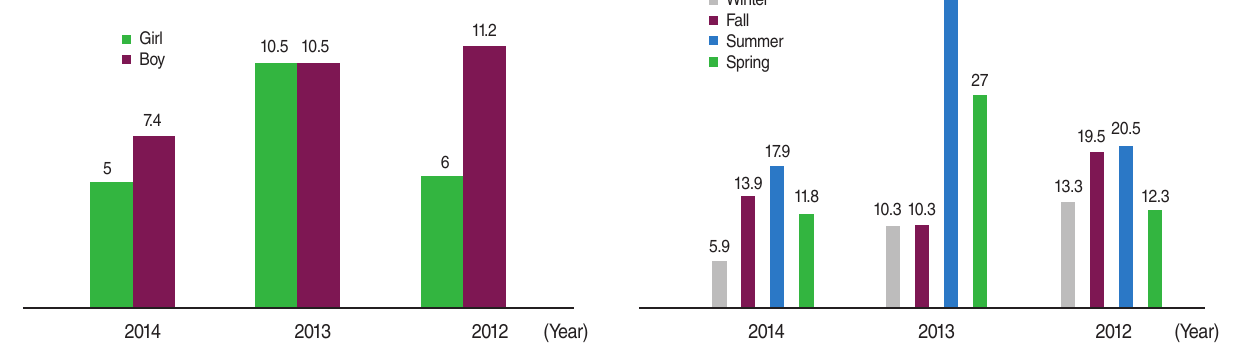
Figure 1. The incidence of congenital hypothyroidism in terms of sex per 1,000 live Table 3. Results of a logistic regression analysis of the effects of participant characteristics on congenital hypothyroidism in Shadegan, Iran Characteristics